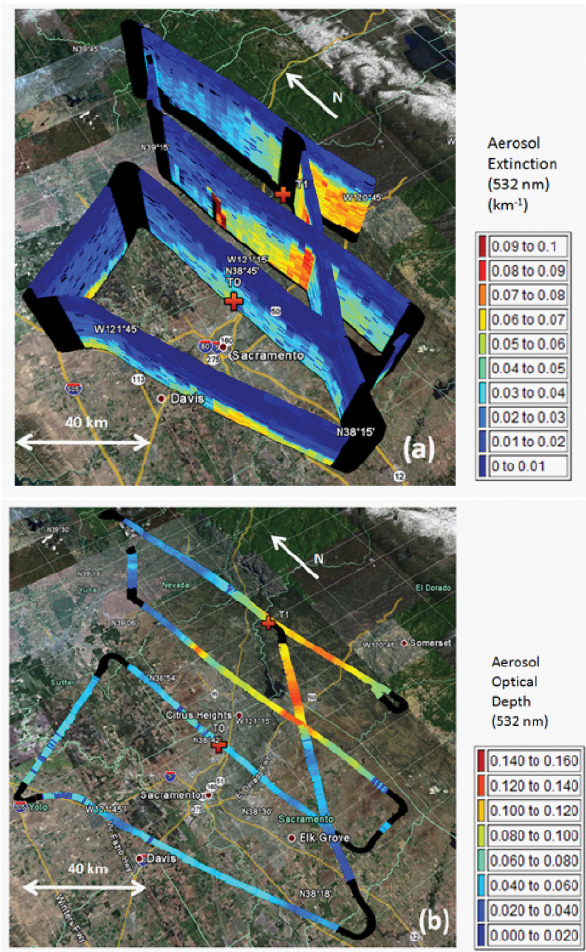
Fig. 24. (a) Aerosol extinction (532nm) profiles derived from air- borne HSRL measurements acquired over the Sacramento region between 15:56 PDT and 17:28 PDT on 28 June. Profiles between the surface and 3km altitude are shown. (b) AOD derived from the HSRL measurements along this same flight track. In both panels the locations of the T0 and T1 ground sites are indicated by red